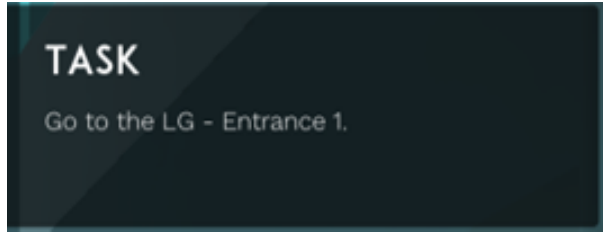
Figure 8. Illustration of the task commands required from the subject to perform in the form of a pop-up card.